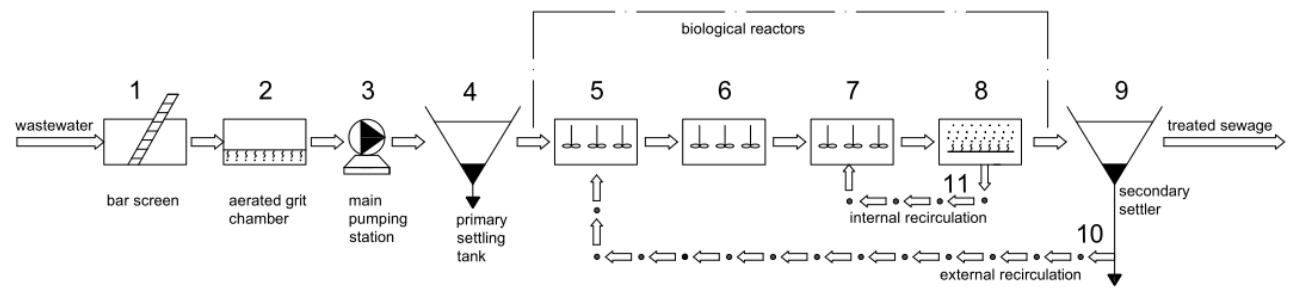
Figure 1. Scheme of the Sitkówka — Nowiny mechanical-biological wastewater treatment plant.